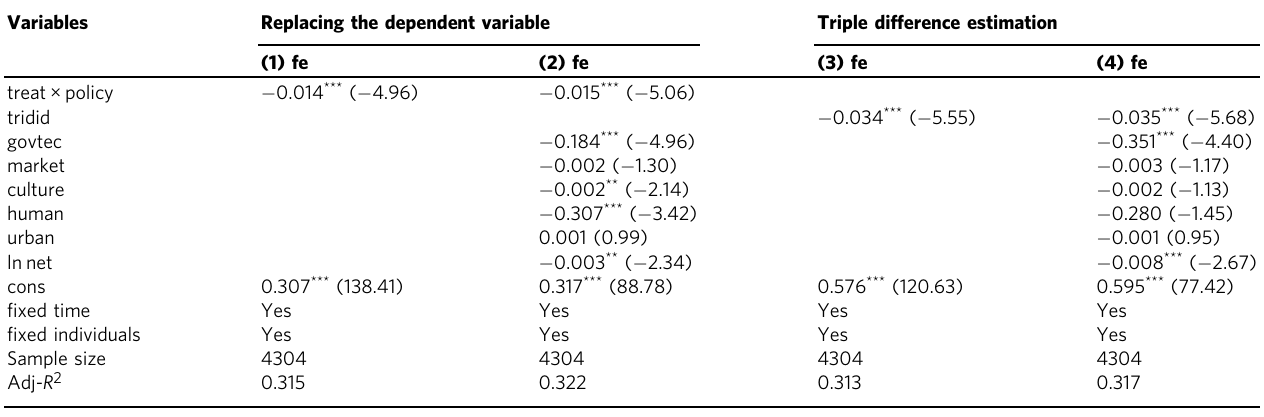
Table 5 Robustness test of the model.